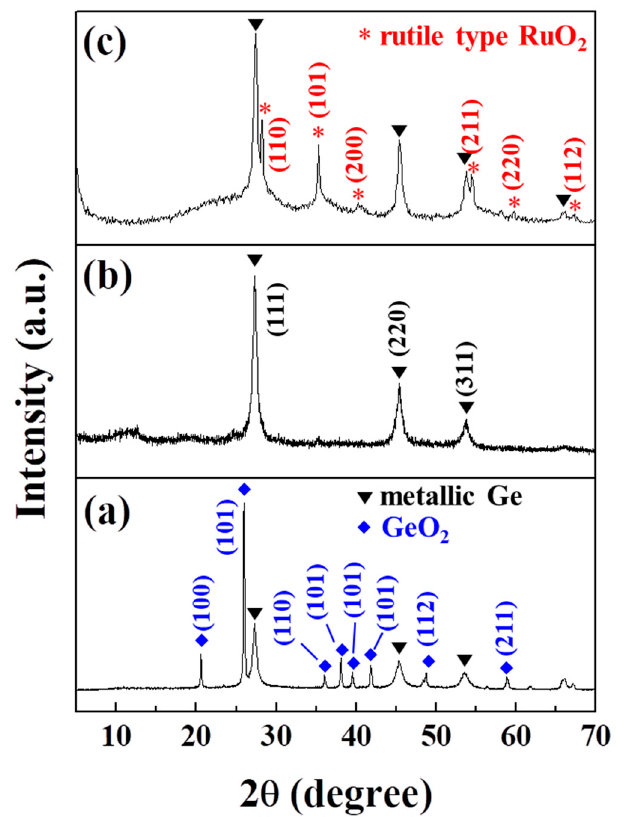
Figure 2. XRD patterns of ( a ) Ge/GeO 2 NPs, ( b ) as-prepared Ge/RuO 2 , and ( c ) Ge/RuO 2 nanocomposite.